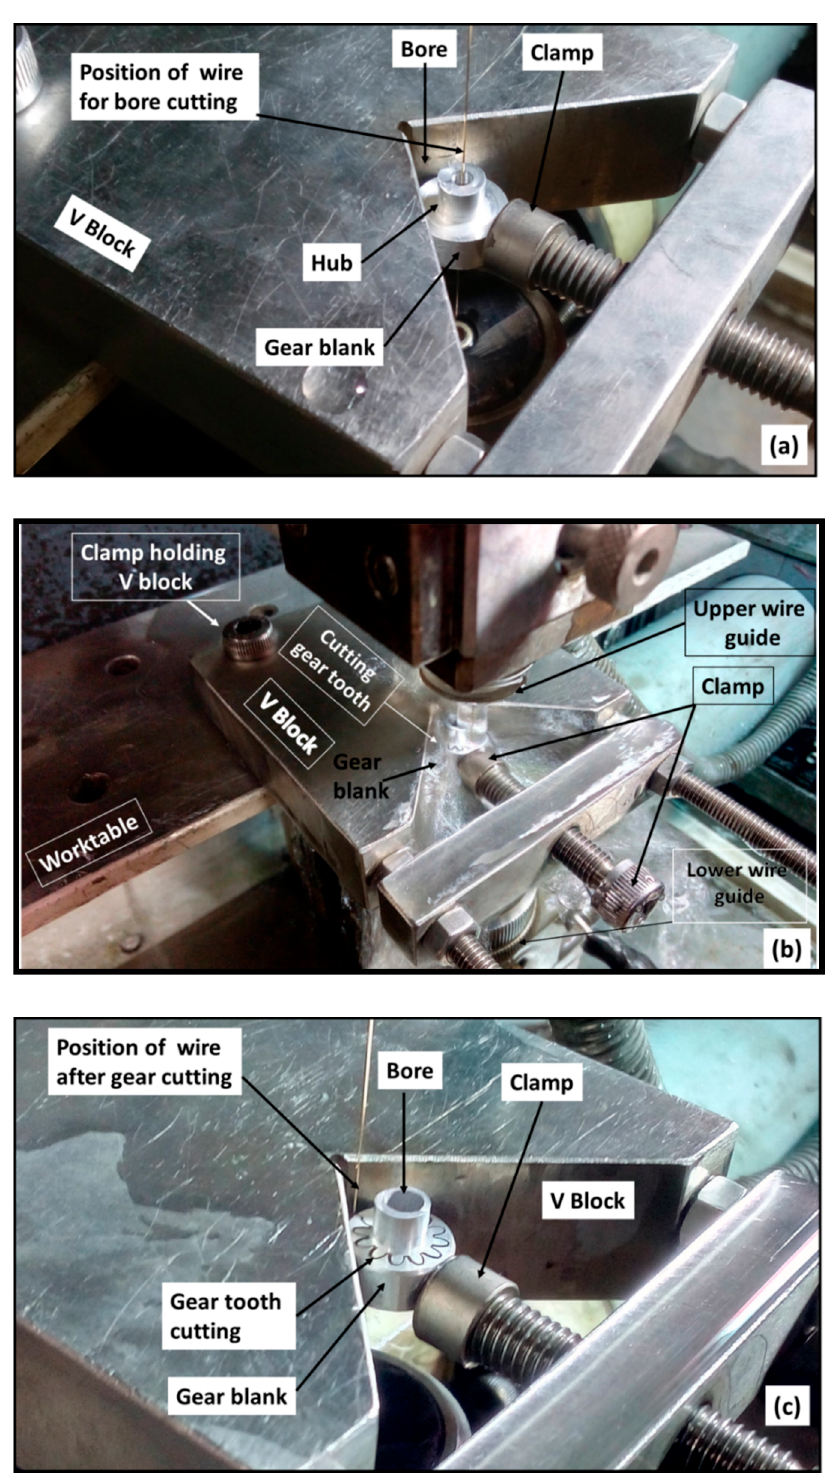
Figure 3. Illustration of different steps involved during cutting of miniature spur gear with bore by WTEM: ( a ) clamping of V block on WTEM worktable and holding gear blank in the V block through the clamp and inserting and positioning wire at the centre of micro-hole for bore cutting; ( b ); cutting of gear teeth; ( c ) positioning of wire after cutting a gear. • Micro-hole (800 μ m diameter) drilling at the centre of the prepared stepped gear blank. The micro-hole acts as an entry path to the brass wire of 250 μ m diameter for manufacturing of bore of miniature gear.